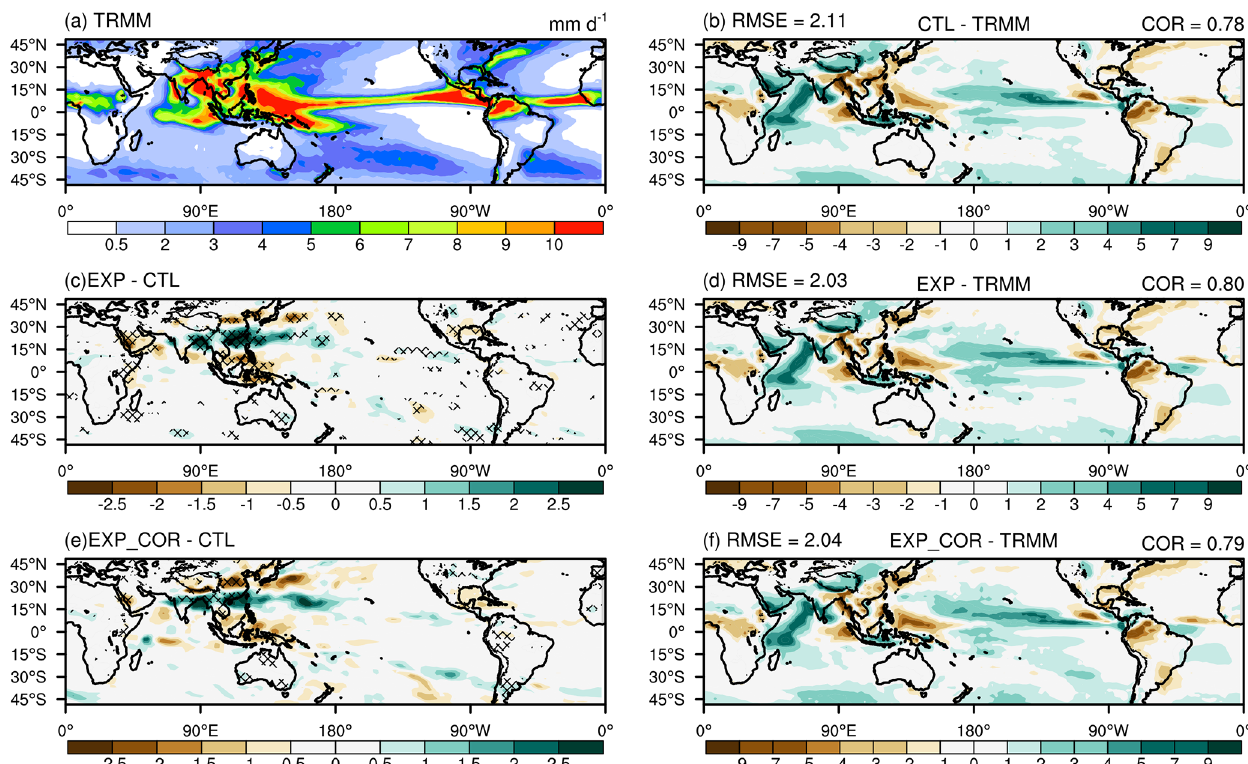
Figure 3. Spatial distributions of JJA (June–July–August) mean precipitation for (a) TRMM; the biases of (b) CTL, (d) EXP, and (f) EXP_COR with respect to TRMM; and the differences (c) between EXP and CTL and (e) between EXP_COR and CTL. The crossed areas are significant at the 95% level. The spatial correlation coefficient (COR) and the root-mean-square error (RMSE) are given at the top of (b) , (d) and (f)